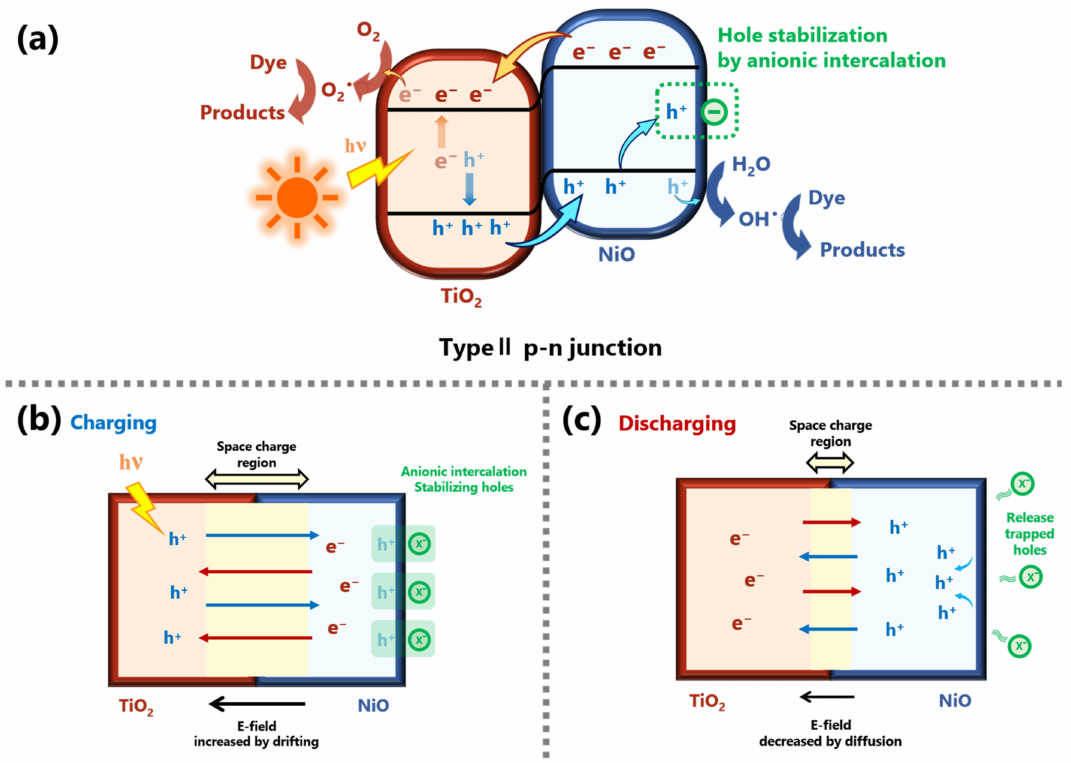
Figure 9. Schematic of: ( a ) photocatalysis on type-II heterojunction photocatalysts, ( b ) charging, and ( c ) discharging processes for AO7 degradation in light and dark